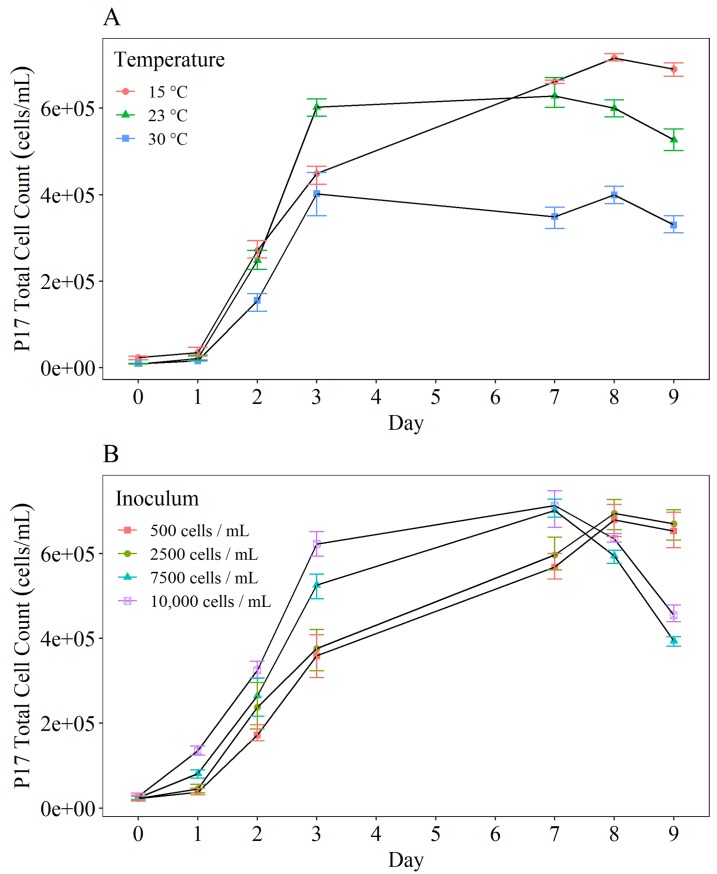
Comparison of P-17 cell growth over a 9 day period when incubated at (A) different temperatures and (B) with different inoculum densities. All samples were enumerated using flow cytometry and recorded as cells/mL. Cells were grown in solutions containing 100 μg acetate carbon/L. (A) Inoculum density was 500 cells/mL, temperature as indicated by the key. (B) Temperature was 15°C, inoculum density as indicated by the key. The average (n = 3) cell counts (± standard deviation) are plotted.